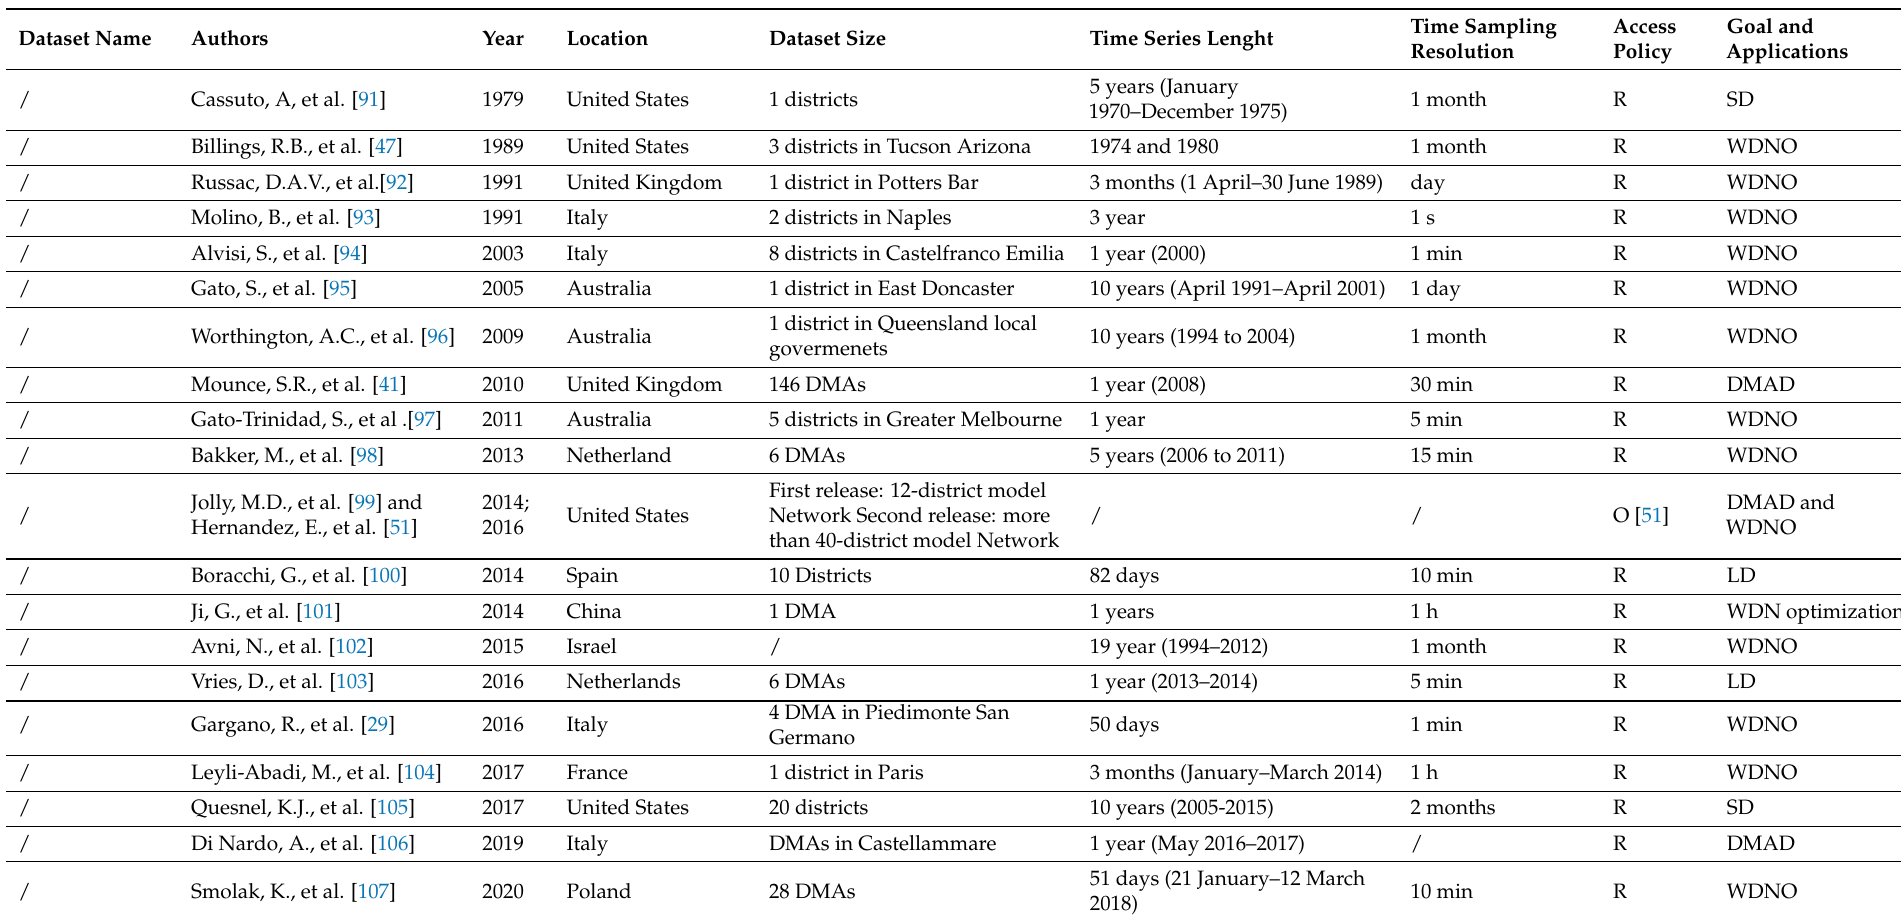
Table 1. Metadata of the 20 reviewed datasets at the district scale. Different goals and applications are considered (see last column): WDNO = Water Distribution Network Optimization; SD = socio-economic studies; DMAD = District Meter Areas Design; LD = Leak